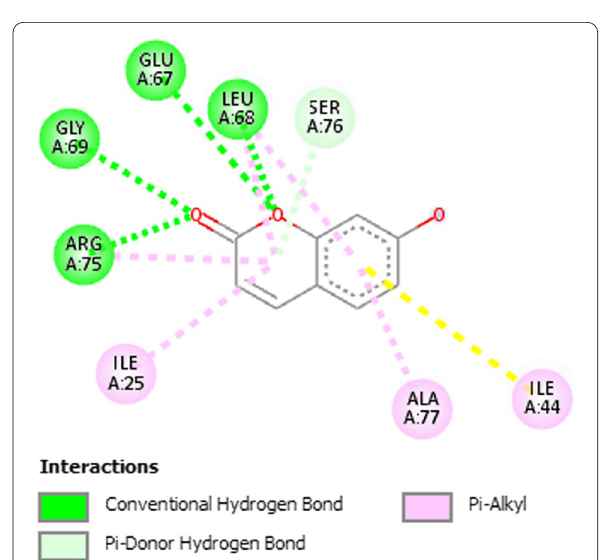
Fig. 13 2D interaction of compound 1 with crystal structure of P. aeruginosa (PDB: 2OZ6)